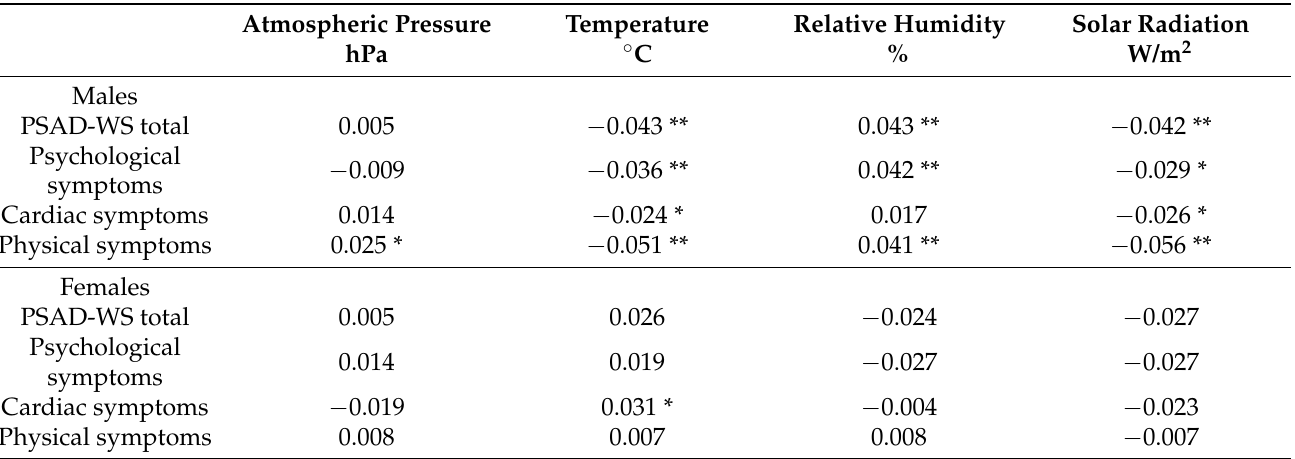
Table 3. Spearman correlation coefficients (r) between weather parameters and daily PSAD-WS, according to